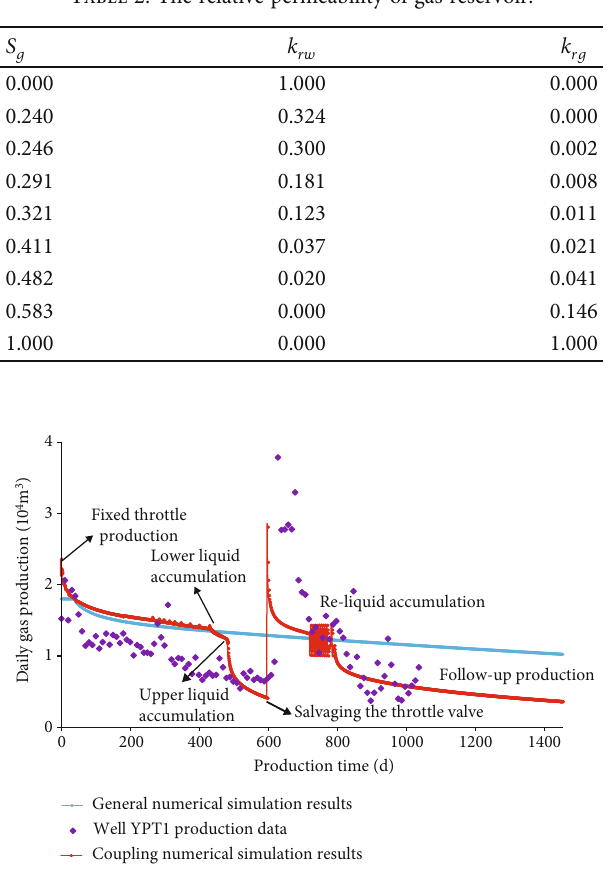
Figure 4: Simulation result of typical gas well.